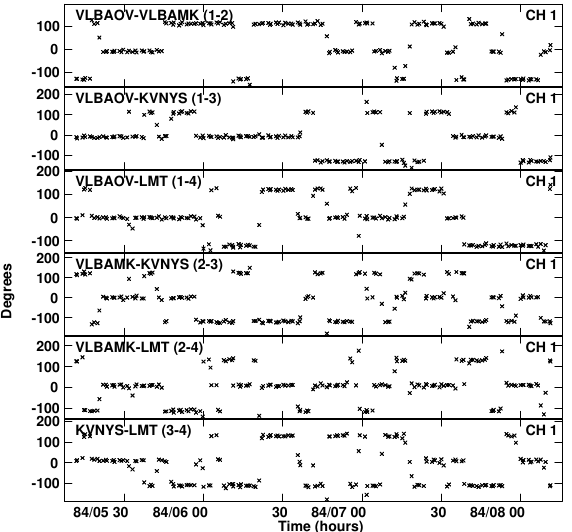
Figure 5. Impact of a non-integer frequency ratio between different observing bands. Here shown are FPT residual visibility phases at 340 GHz after calibration with simultaneous 255 GHz band observations and a calibration timescale equal to 15 s, under Good weather conditions. Phase jumps are a consequence of occasionally failing to track ambiguities. When ambiguity is lost a phase jump of ± 120 ◦ is